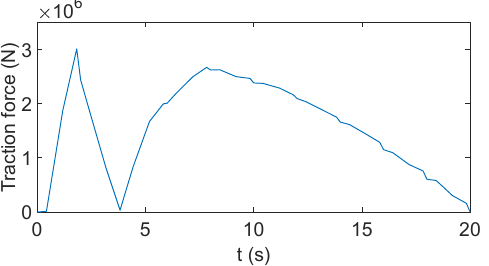
Figure 11. The change of cable traction force in trajectory optimization.